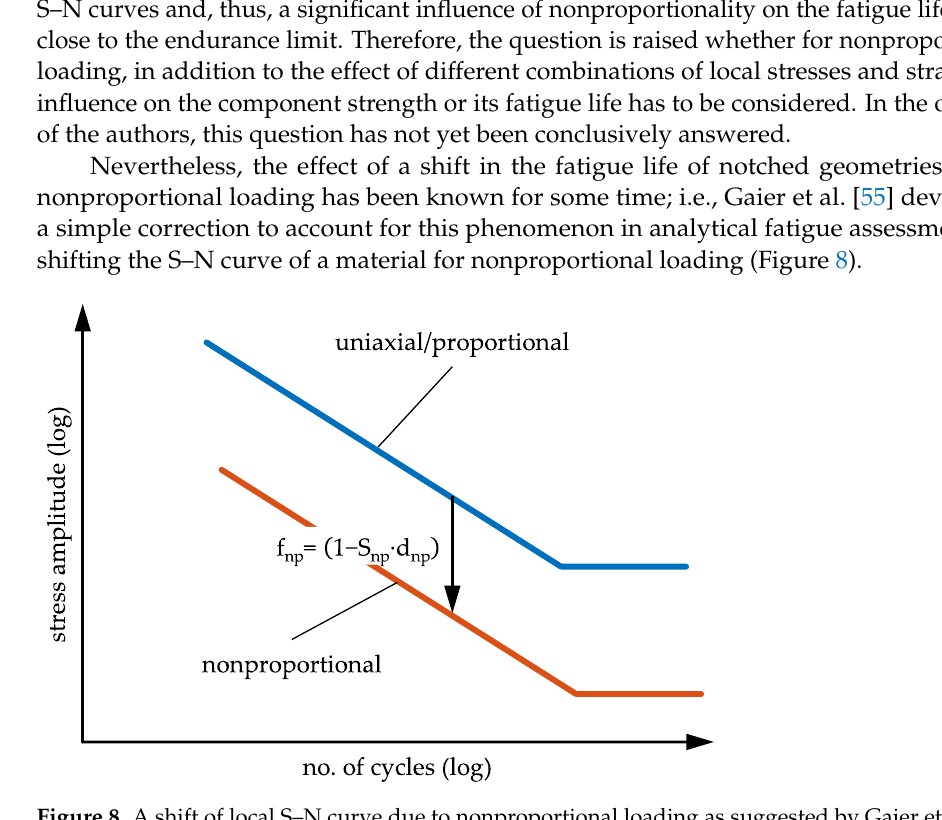
Figure 8. A shift of local S – N curve due to nonproportional loading as suggested by Gaier et al.